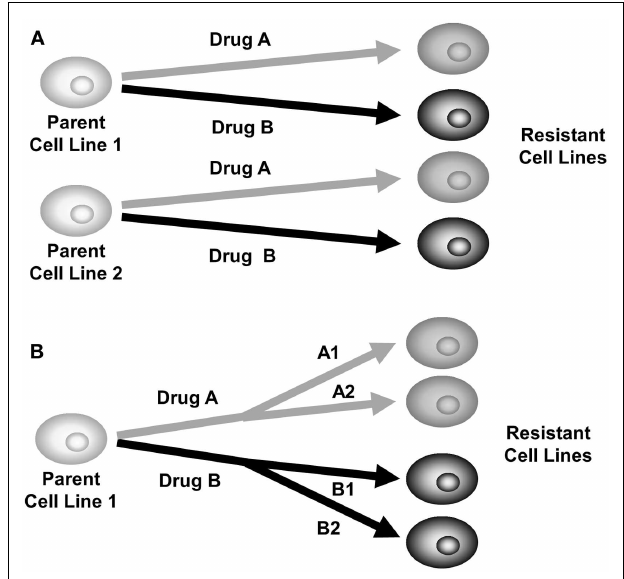
FIGURE 2 | Comparative selection of drug-resistant cell lines . (A) Plan for selection of two parent cell lines with two different drugs to produce four drug-resistant daughter cell lines. (B) Plan for selection of one parent cell line with two drugs at different doses or treatment intervals, producing four drug-resistant daughter cell